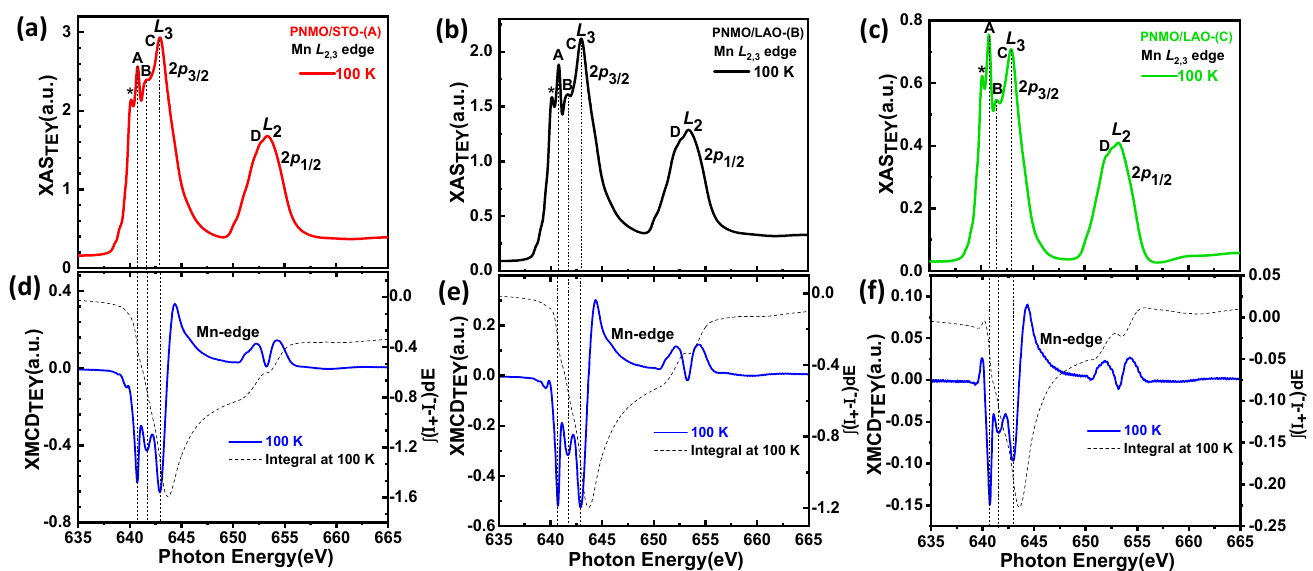
Figure 7. Experimental Mn- L 2,3 XAS spectra for ( a ) PNMO/STO-(A), ( b ) PNMO/LAO-(B), and ( c ) PNMO/LAO-(C) samples at 100 K. The respective XMCD signals are plotted in the ( d – f ) panels, where the dashed black line shows the corresponding XMCD integrals.